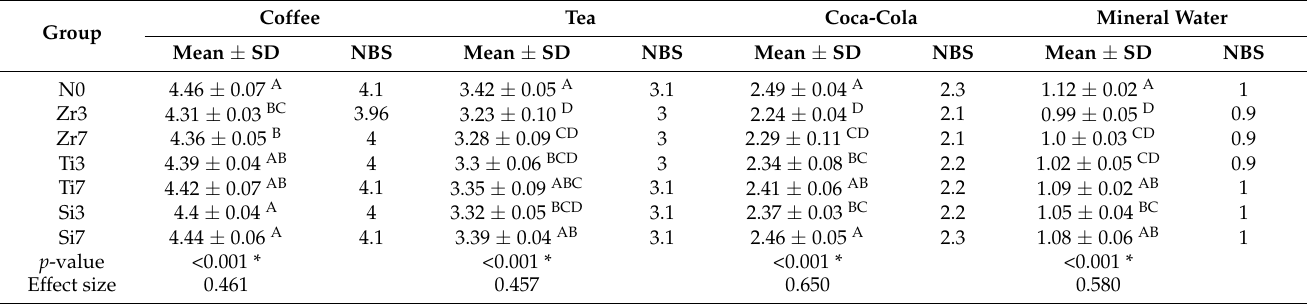
Table 3. ( ∆ E) mean (M) values, standard deviations ( ± SDs), and significance between tested groups in terms of immersion solution